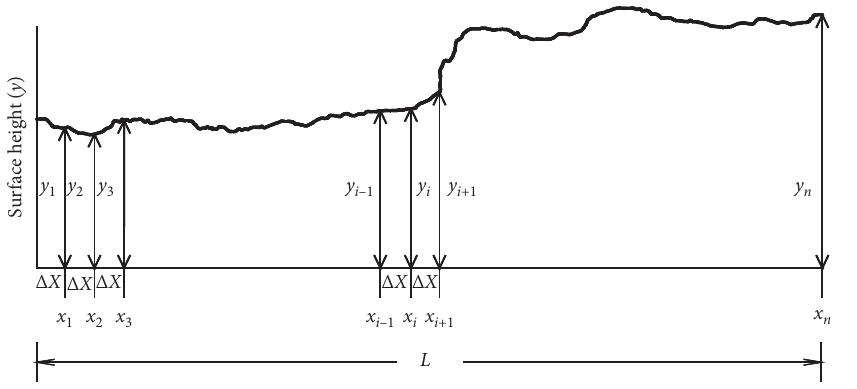
Figure 1: The diagram used to define geometric coordinates of a joint profile